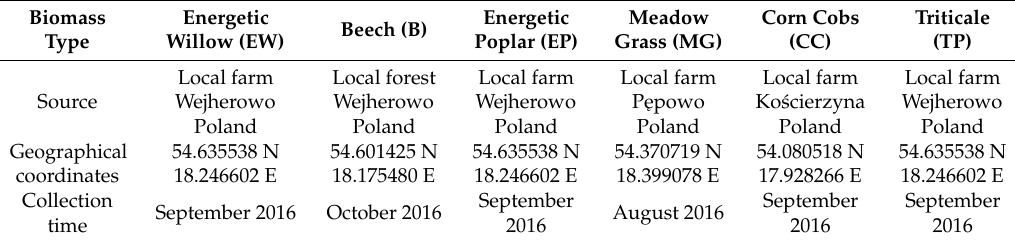
Table 7. Places of origin and time of harvesting samples of wood (EW, EP and B), cereals (CC and TP) and grass